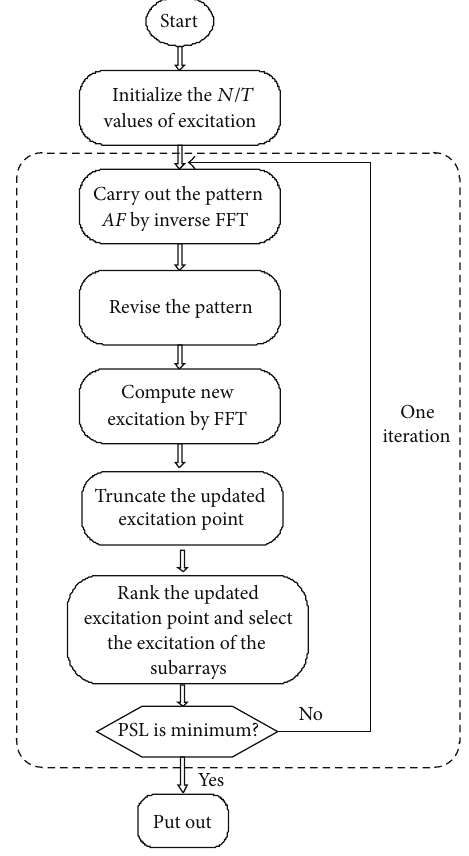
Figure 1: Flowchart of the MIFT